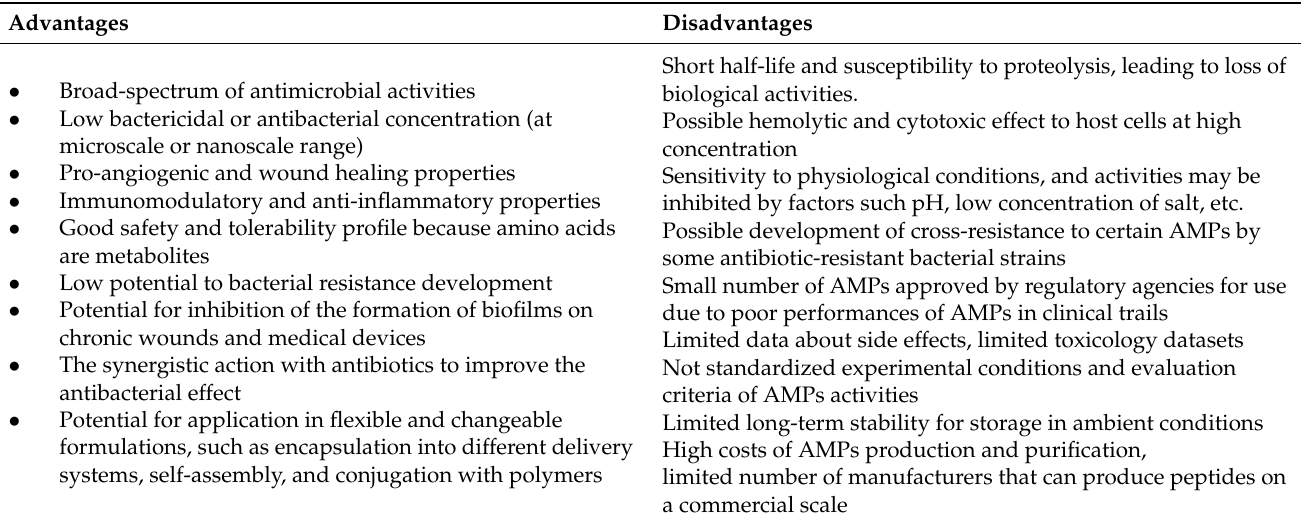
Table 1. Advantages and disadvantages of AMPs for therapeutic applications in regenerative medicine.